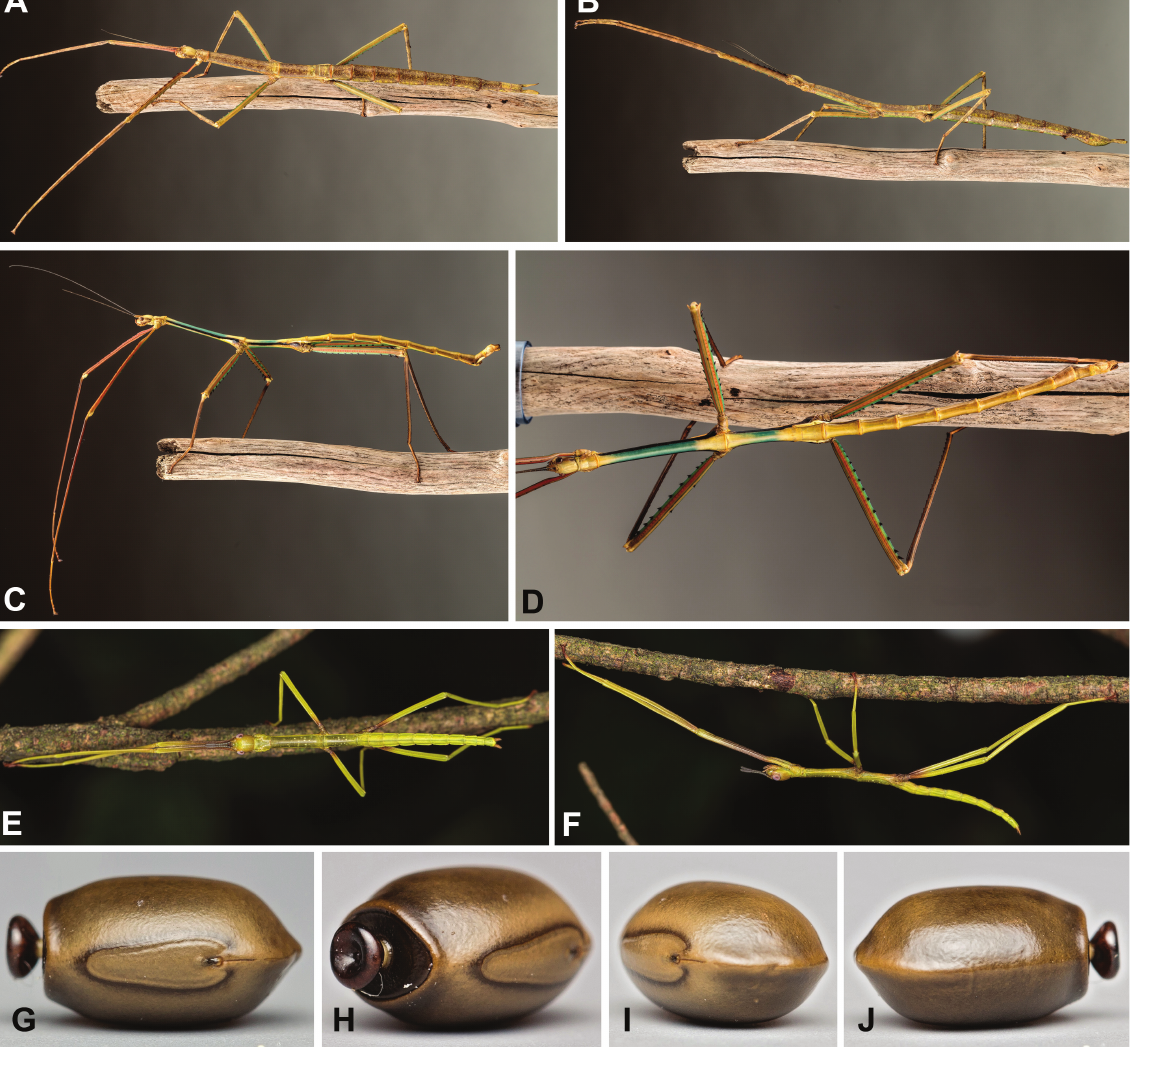
Fig. 6. Phryganistria tamdaoensis sp. nov., captive reared, from Tam Dao N.P. (photographs by Dr Bruno Kneubühler). A . ♀, dorsal view. B . ♀, lateral view. C . ♂, lateral view. D . ♂, dorsal view. — E–F . Freshly hatched nymph. E . Dorsal view. F . Lateral view. — G–J . Egg. G . Dorsal view. H . Detail of operculum and capitulum. I . Polar area. J . Ventral